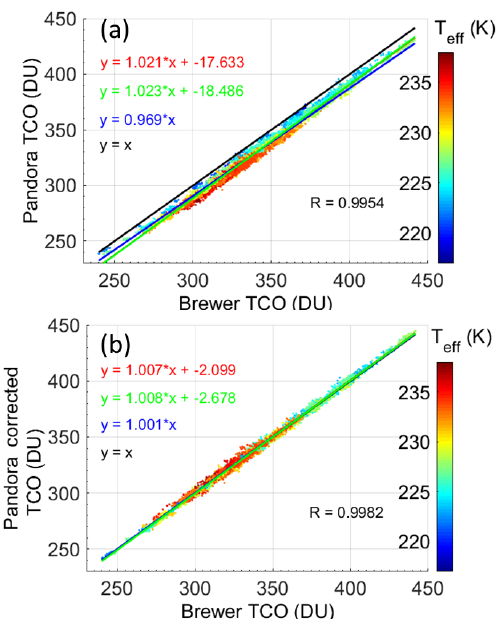
Figure 8. Scatter plots of Pandora no. 103 vs. Brewer no. 14 TCO, colour-coded by ozone effective temperature: (a) before applying the correction and (b) after applying the correction. The red line is a simple linear fit, the green line is the linear fit weighted by the calculated standard uncertainty from Pandora and Brewer TCO data, the blue line is the linear fit with intercept set to 0, and the black line is the one-to-one